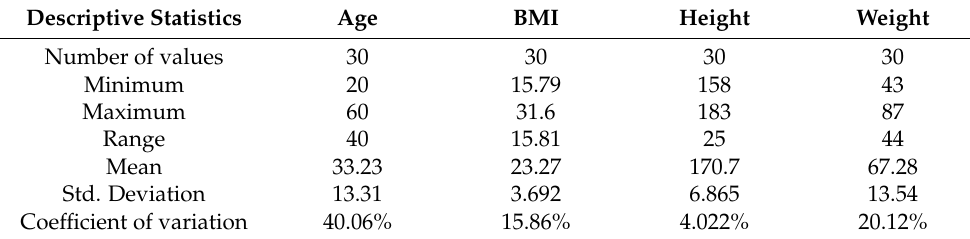
Table 1. Descriptive data of the sample.